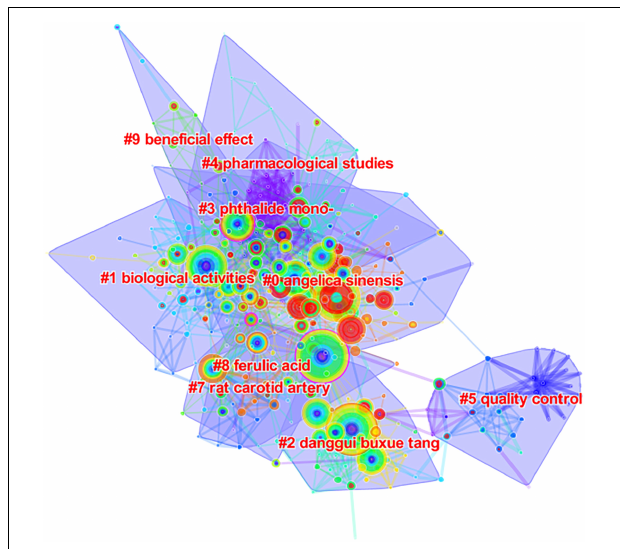
FIGURE 4 | The cluster map of document co-citation of Angelica sinensis